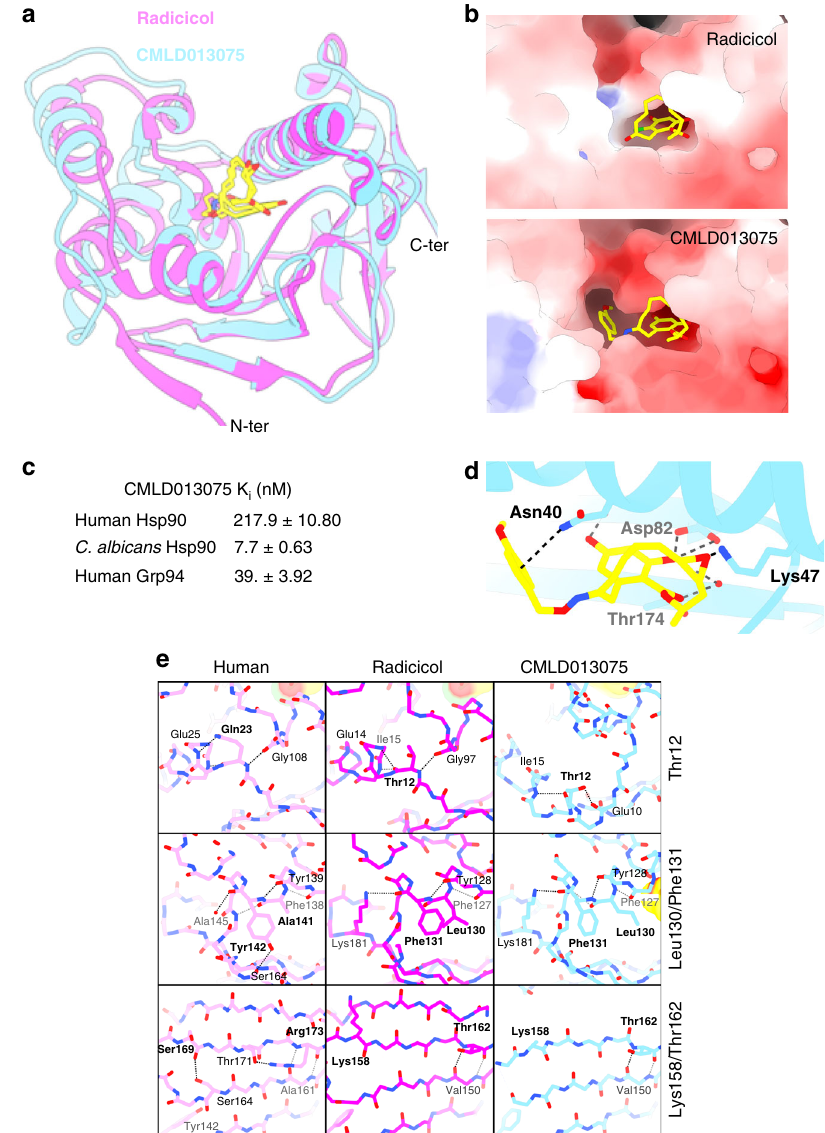
Fig. 4 Structure of Hsp90 nucleotide-binding domain (NBD) in complex with CMLD013075. a Ribbon representation of a 2.6 Å resolution crystal structure of CMLD013075 (blue) bound to C. albicans Hsp90 NBD. Radicicol from a separate C. albicans co-crystal (magenta) is overlaid. The ligands are represented as sticks and color-coded according to their heteroatom composition. b Detailed view of the binding mode of radicicol (top) and CMLD013075 (bottom) to C. albicans Hsp90. A surface representation is provided and color-coded by electrostatic potential ( − 10 to 10kT/e blue to red color ramp). c Binding af fi nities for CMLD013075 were determined by equilibrium competition FP assay using puri fi ed human Hsp90, fungal Hsp90, and human Grp94 NBDs and are indicated as K i values. Assays were repeated in three independent experiments. The mean ± SEM is presented. Source data for the determination of binding af fi nities are provided as a source data fi le. d Polar contacts for the resorcinol-containing compound CMLD013075 in complex with C. albicans Hsp90 NBD. Protein residues engaged in H-bonds or cation – π interactions are labeled, and those interactions shown as dashed black lines. e H-bond networks of the residues selected for mutagenesis (bold residue names). Two fungal Hsp90 co-crystal structures are shown, radicicol (magenta),